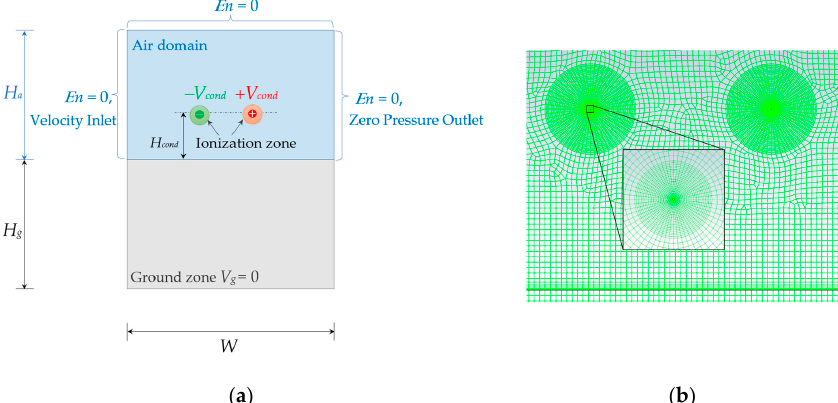
Figure 3. Calculation domain: ( a ) zones and boundary conditions; ( b )